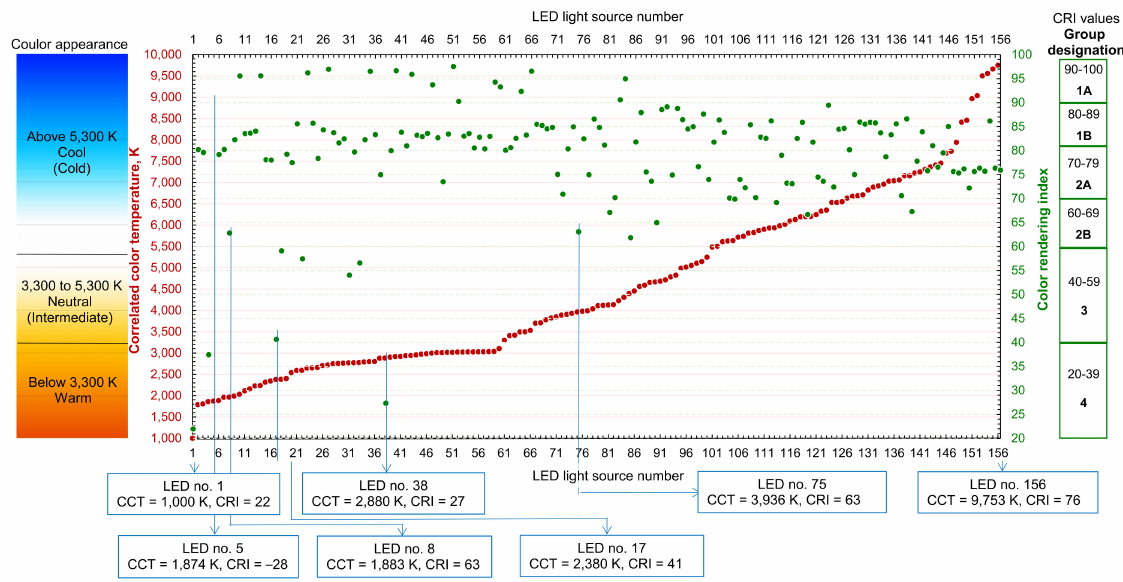
Figure 5. Graphical presentation of CCT and CRI for the 156 LED sources